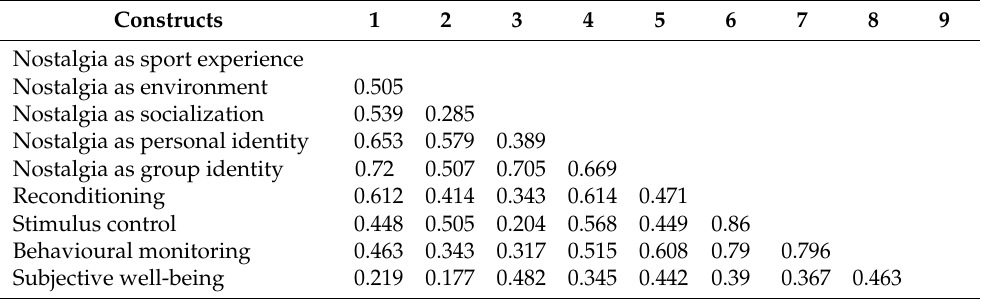
Table 3. Discriminant validity—HTMT.